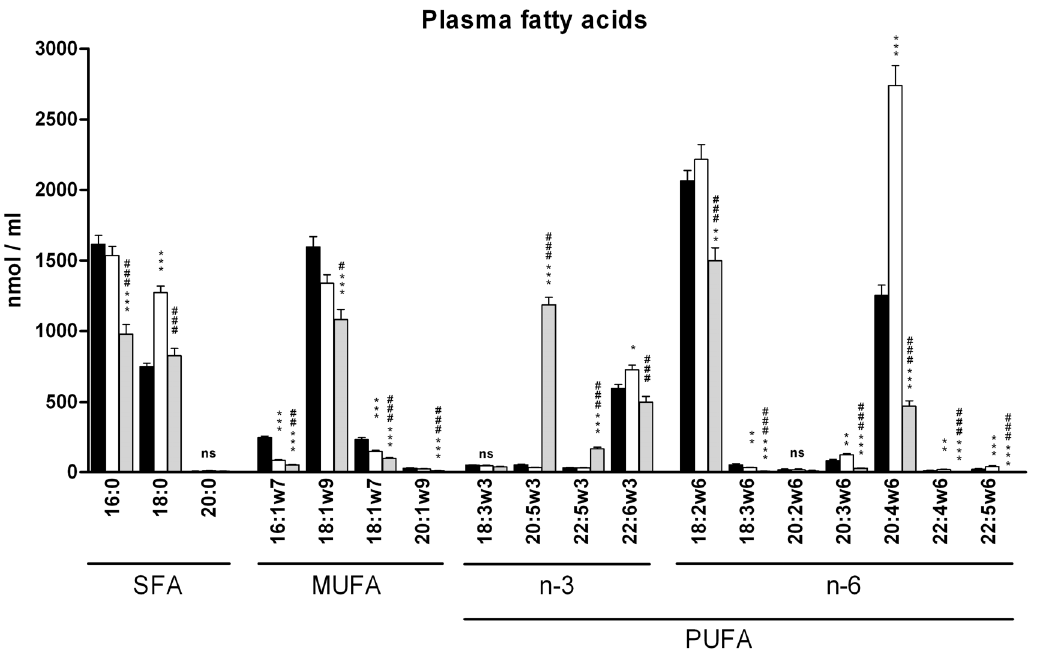
Figure 1. Plasma lipid composition. SFA (Saturated Fatty Acids), MUFAs (Mono-Unsaturated Fatty Acids) and PUFAs (Poly-Unsaturated Fatty Acids) were measured by gas-liquid chromatography in plasma of fasted mice after 10 weeks feeding with ND (black column, n=6), HFD (white column, n=12) or HFD + EPA (grey column, n=9). Data are expressed as mean 6 SEM. *p , 0.05, **p , 0.01, ***p , 0.001 vs ND; # p , 0.05, ## p , 0.01, ### p , 0.001 vs HFD. ns: not